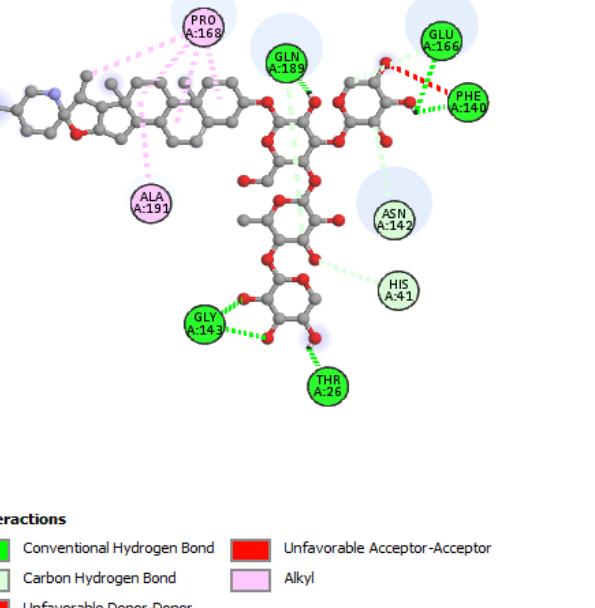
Figure 2 . Interaction of incanumine with Mpro ( without N3 ).